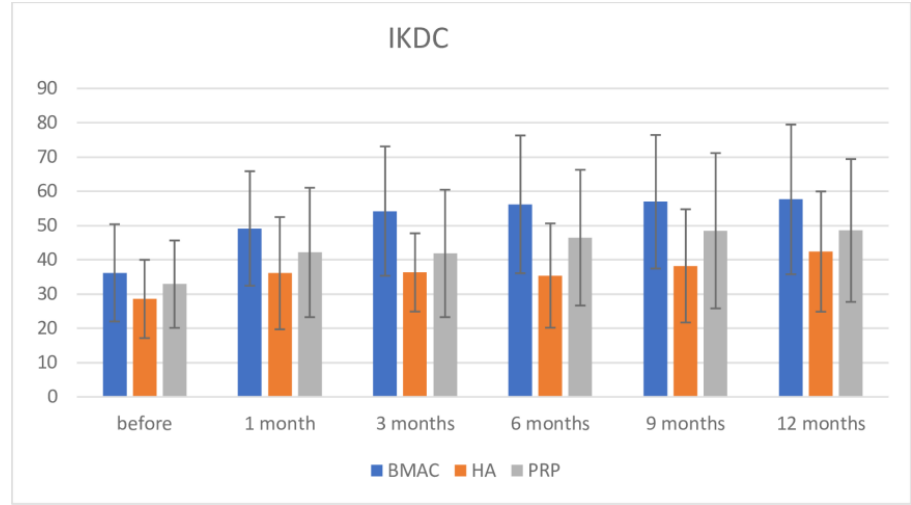
Figure 6. IKDC scale before intervention and after 1, 3, 6, 9, and 12 months.